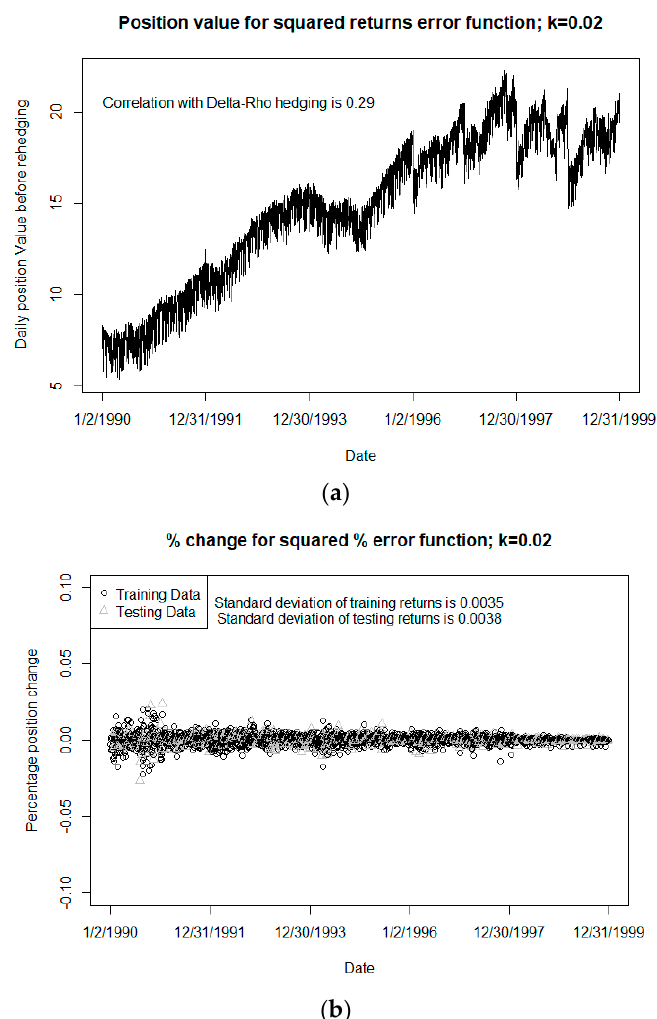
Figure 5. Results for hedging for GMDB using k = 0.02 error function: ( a ) The daily position value over the 10-year life of the VA contract; ( b ) the daily percentage change in the position over the life of the contract, including both training and testing.